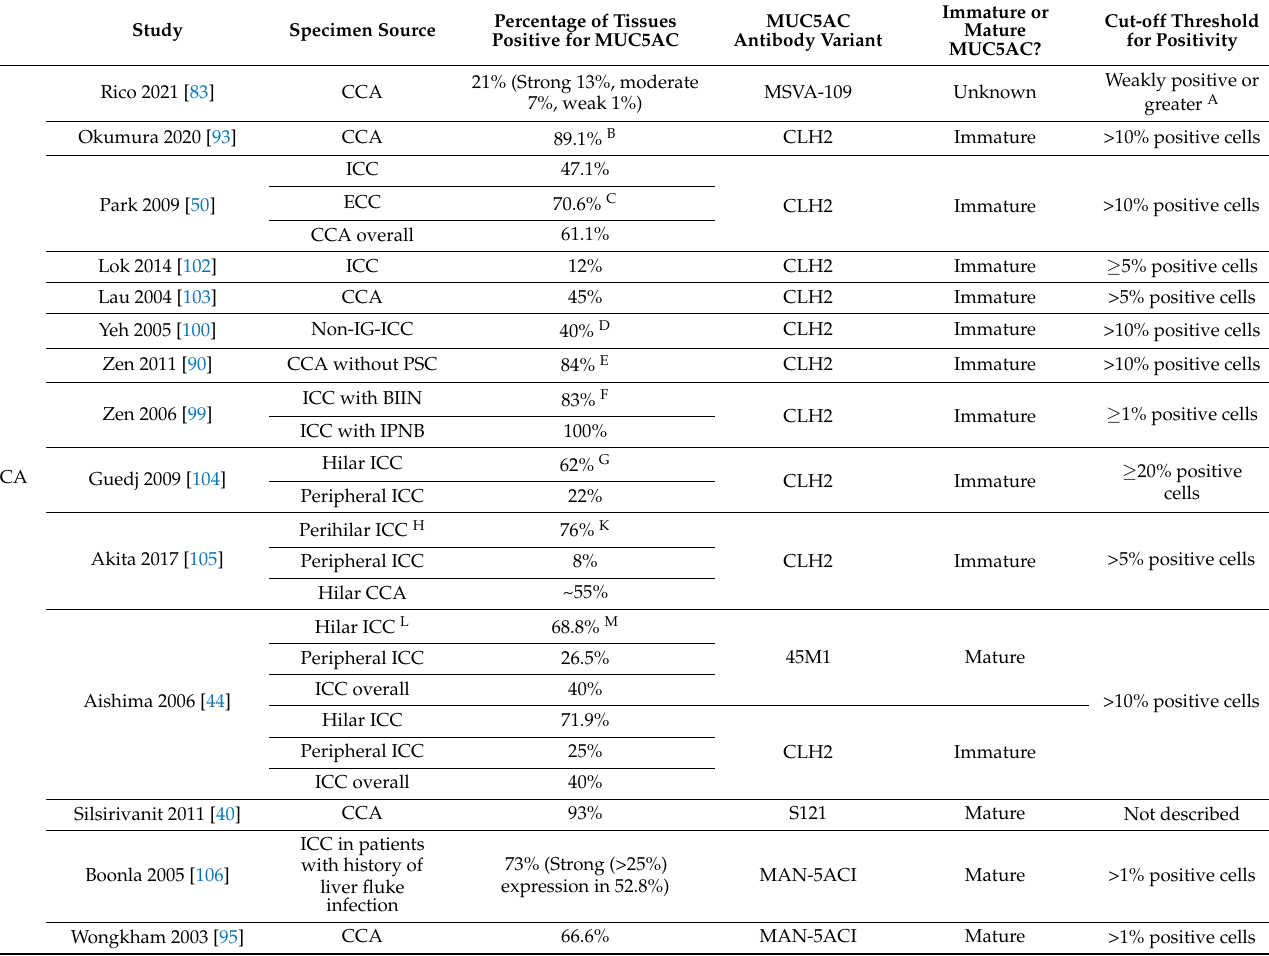
Table 2. MUC5AC Expression in BTC Tissues (via IHC